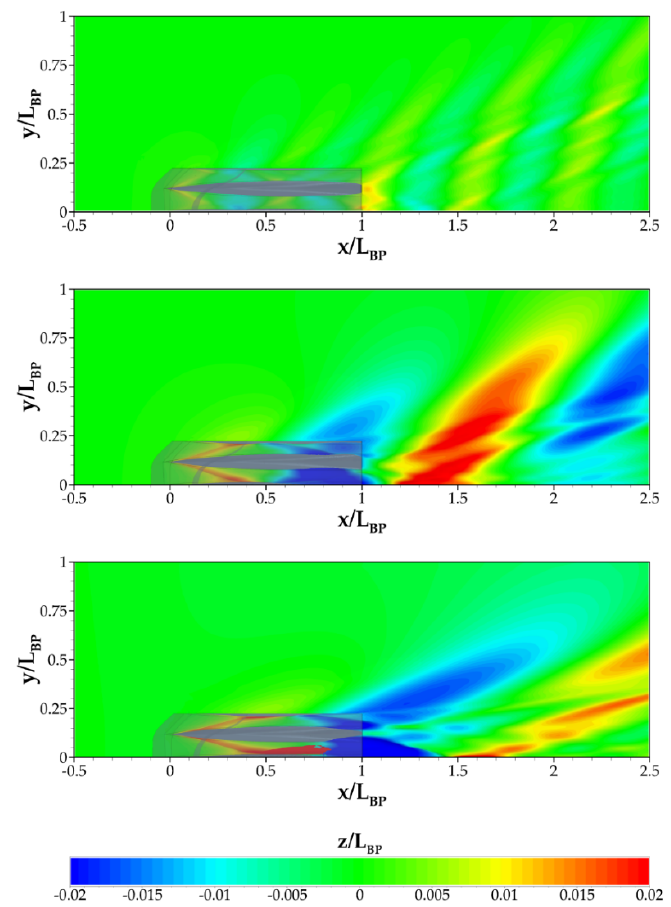
Figure 8. Free surface deformations of the Double-M craft body in calm water, from top to bottom Fr = 0.3, Fr = 0.5 and Fr = 0.7, respectively.